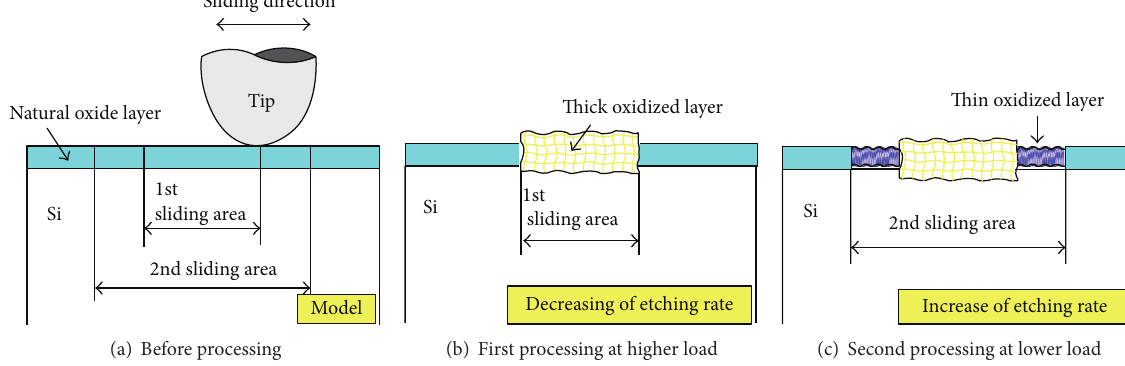
Figure 15: Model of a nanofabrication process using mechanochemically and naturally oxidized areas as etching masks. (a) Before processing, (b) during the first processing step at high load, and (c) during the second processing step at low load.